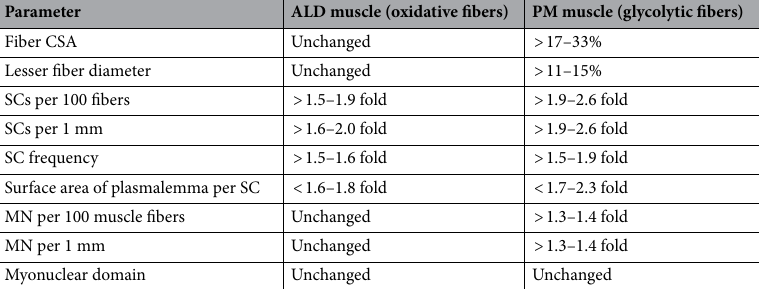
Table 3. Distinct mesterolone-induced changes in fiber size and cellular parameters of anterior latissimus dorsi (ALD) and pectoralis major (PM) muscles. CSA: cross-sectional area; SC: satellite cell; MN: myonuclei.